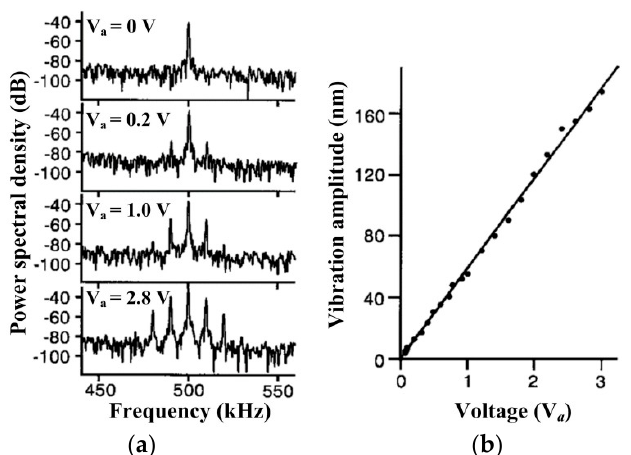
Figure 9. ( a ) Power spectra (long-time average) for several applied voltages. ( b ) Maximum vibration amplitude versus voltage applied to the speaker. Carrier frequency, 500 kHz; modulation frequency, 8.42 kHz. (Figure reproduced from Ref. [16]).